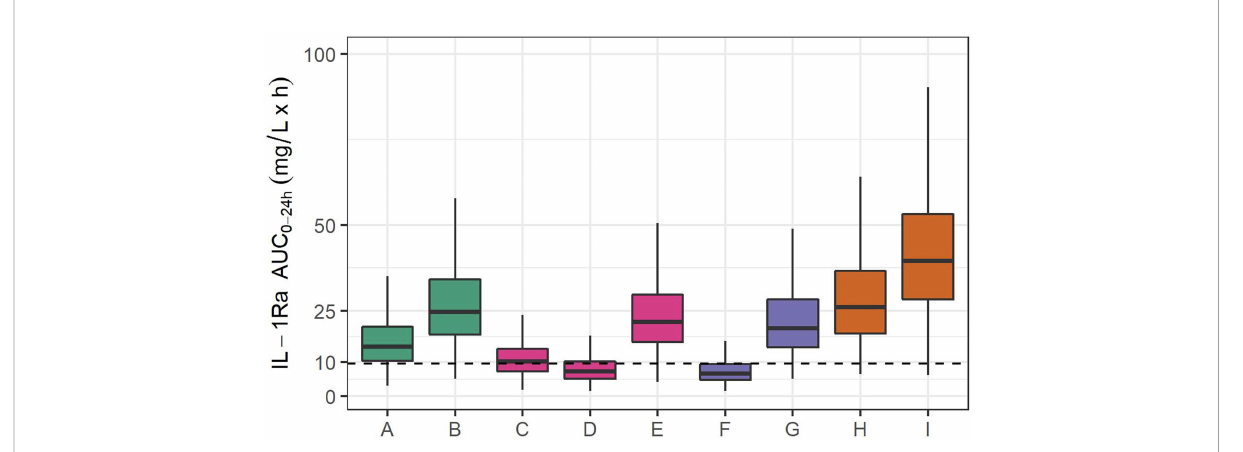
FIGURE 3 IL-1Ra plasma exposure (AUC 0-24 ) from 1000 simulations, in studied populations and extrapolated to extremely premature neonates. Simulated exposure for (A) a 70 kg adult receiving 100 mg daily, (B) a 70 kg adult with severe renal impairment receiving 100 mg daily, (C) a 70 kg adolescent receiving 1 mg/kg daily, (D) a 2-year-old child weighing 12 kg and receiving 1 mg/kg daily, (E) a 12 kg 2-year-old child receiving 3 mg/kg daily. Simulations in extrapolated PK: (F) an extremely premature neonate (25-weeks GA, 850 g) with mature non-renal clearance receiving 1 mg/kg alternate daily, (G) an extremely premature neonate receiving 1.5 mg/kg daily, (H) an extremely premature neonate with 25% function of non-renal clearance receiving 1 mg/kg alternate daily, and (I) an extremely premature neonate with 25% function of non-renal clearance receiving 1.5 mg/kg daily. The dashed line indicates the threshold of 9.6 mg/l x h identi fi ed in (28) as the exposure above which suf fi cient suppression in auto-immune disease is